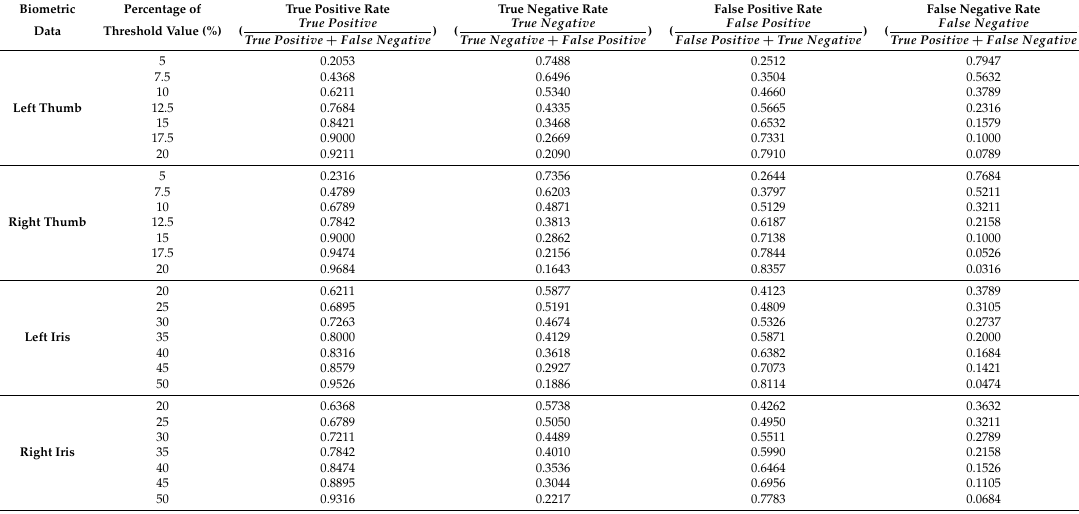
Table 3. Performance Evaluation Results (2): The performance evaluation of the infected cross-layer biometric recognition system for four biometric